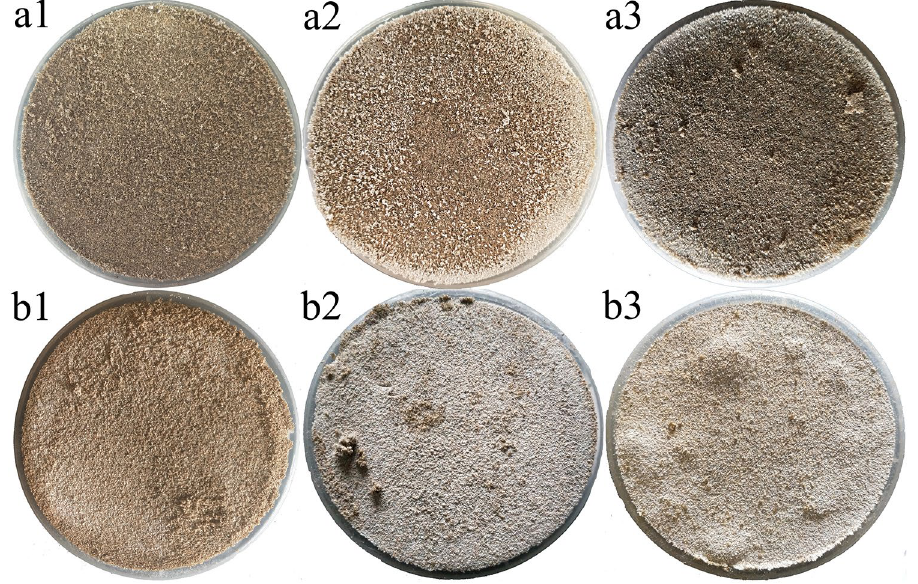
Figure 1. Images of salt crust formed by sodium sulfate or calcium chloride: ( a ) denotes sodium sulfate salt and ( b ) denotes calcium chloride salt. Numbers 1, 2 and 3 represent soil salt contents of 2%, 4% and 6%, respectively. For example, a1 represents the sodium sulfate salt crust with a salt content of